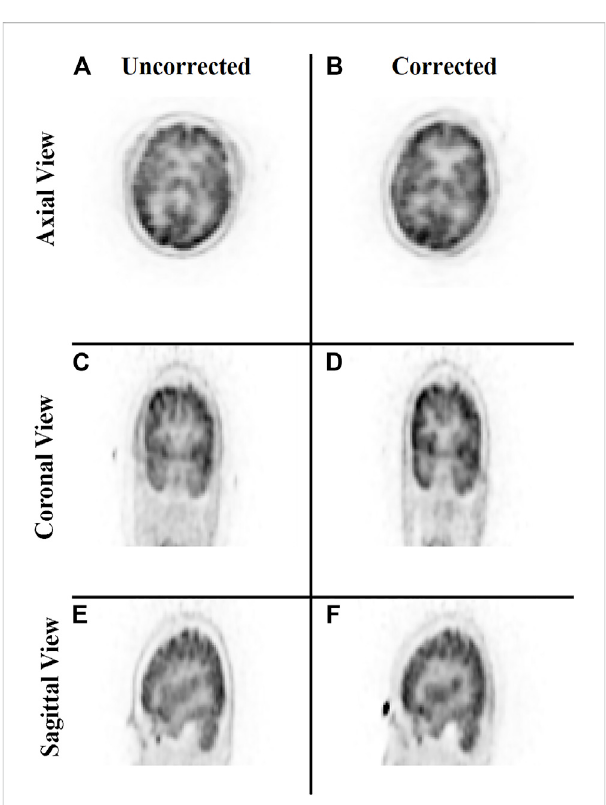
FIGURE 9 Qualitative comparison of the neural network performance in motioncorrectionby remapping raw listmode data. Rows from top to bottom show the sum of the three frames without any correction (A,C,E) and correction using the deep learning approach (B,D,F) , respectively, in the axial, coronal, and sagittal